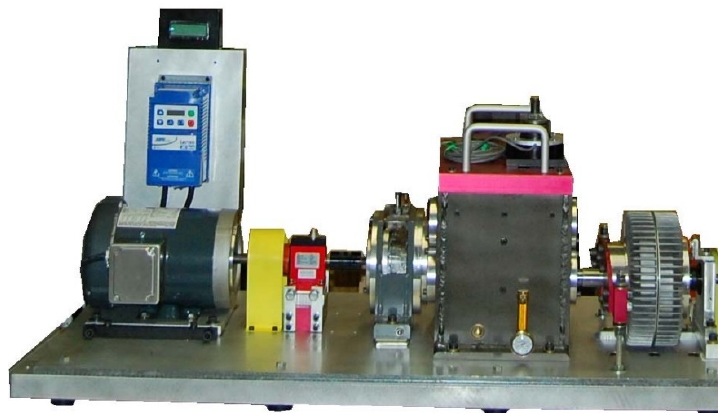
Figure 9. The test rig of DDS.